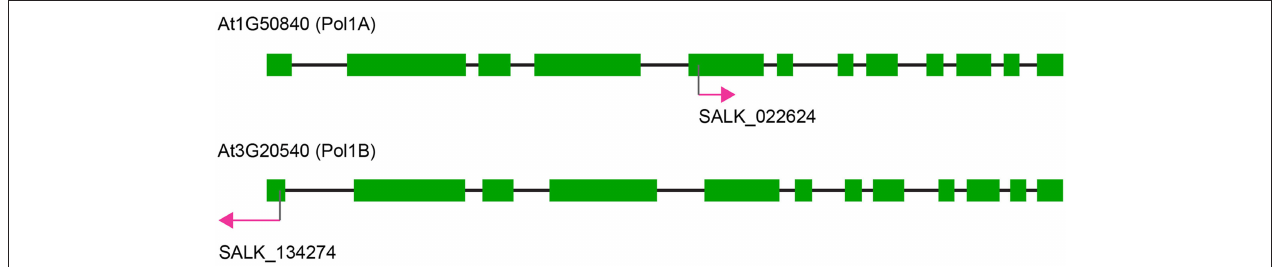
FIGURE 1 | Map of the DNA polymerase genes and T-DNA insertions. Note the overall similarity between both genes for Pol1A and Pol1B. Both genes possess 12 exons although SALK_022624 inserts in the fifth exon of Pol1A whereas SALK_134274 inserts in the first exon of